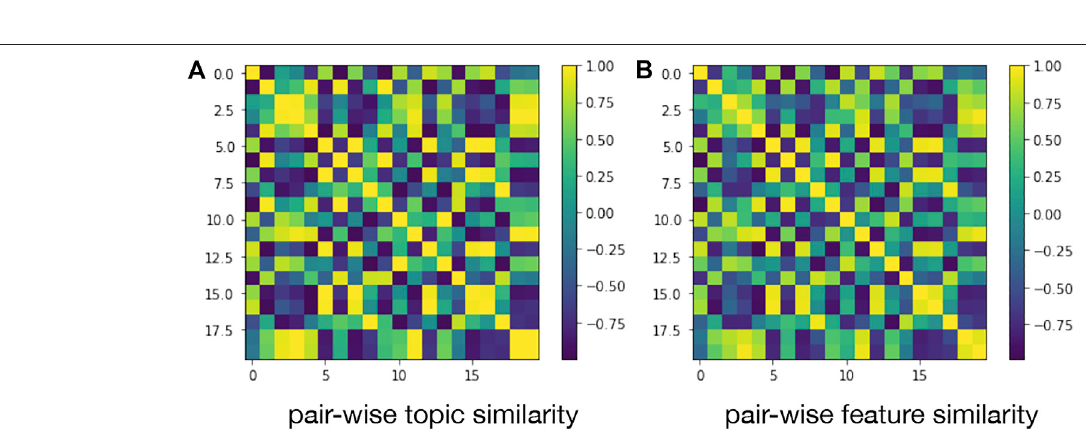
FIGURE 8 | Illustration of Point-wise Alignment with sample communities.